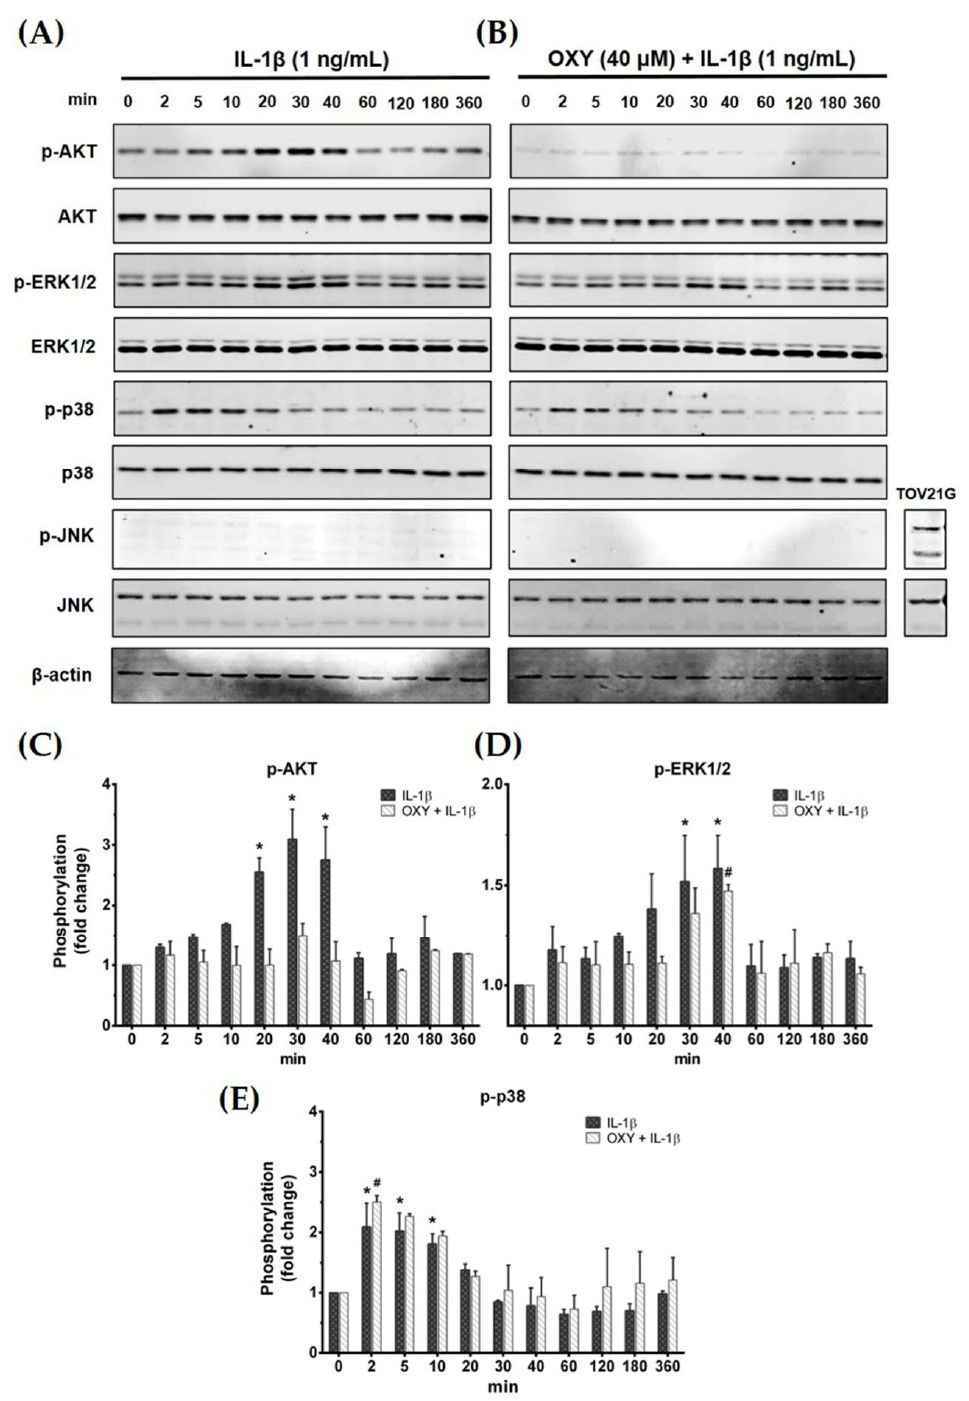
Figure 4. ( A ) The phosphorylation status of PI3K / AKT kinase and MAPKs, including ERK1 / 2, p38, and JNK, of IL-1 β -induced HMC3 cells at 0 to 360 min; ( B ) the e ff ects of OXY on suppressing the phosphorylation of AKT, ERK1 / 2, p38, and JNK after IL-1 β activation; total proteins were detected and used as an internal control; ( C ) quantitative analysis for phosphorylated AKT (Ser473); ( D ) quantitative analysis for phosphorylated ERK1 / 2; ( E ) quantitative analysis for phosphorylated p38. Data are represented as mean ± SD of three independent experiments; # p < 0.05 (compared to the IL-1 β -treated group after 0 min induction) or * p < 0.05 (compared to the OXY + IL-1 β -treated group after 0